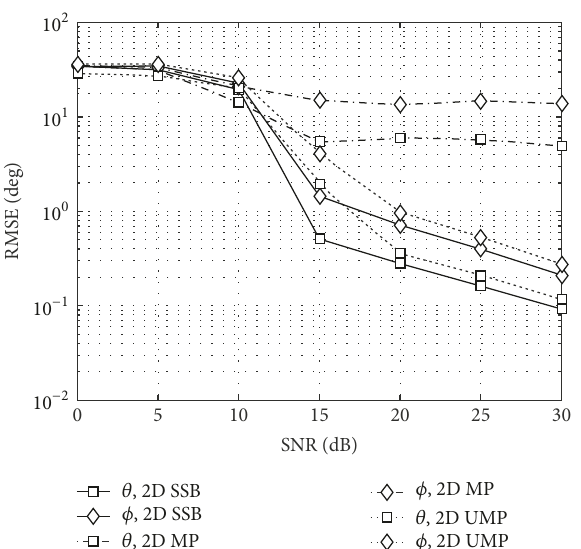
Figure 5: RMSEs of azimuth and elevation angles against with SNR for uncorrelated sources, where (𝜃 1 , 𝜙 1 ) = (25 ∘ ,55 ∘ ) and (𝜃 2 , 𝜙 2 ) = (45 ∘ , 65 ∘ ) .